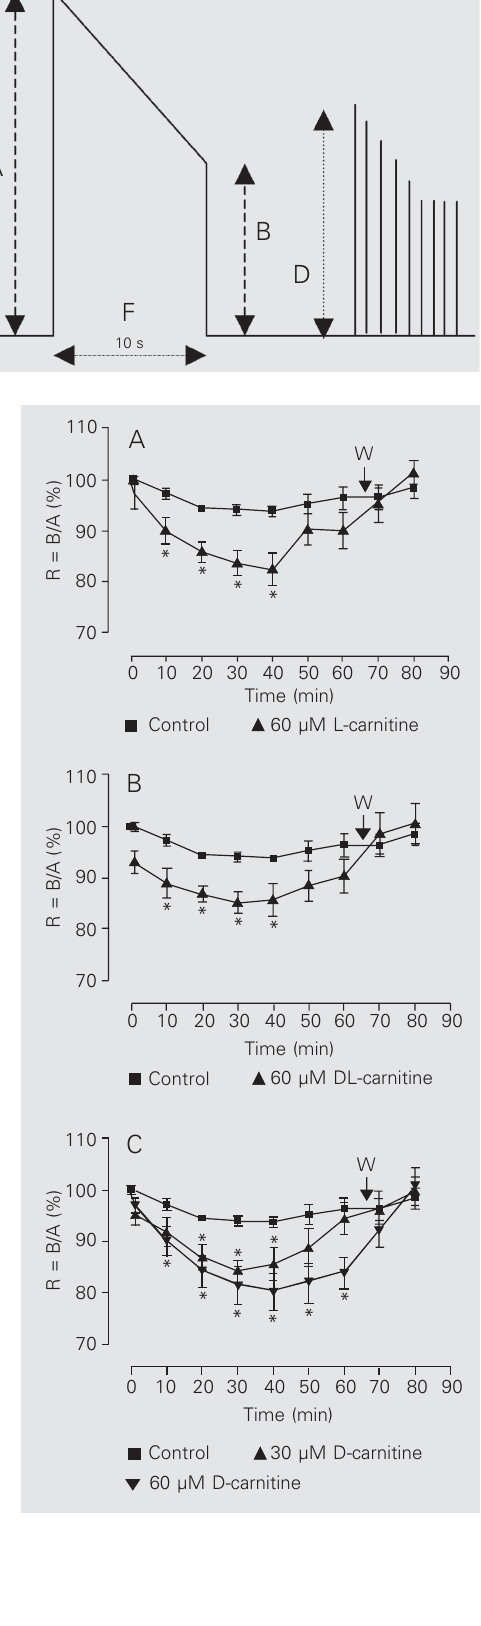
Figure 1. Representation of the contractile responses of rat skeletal muscle during tetanic stimulation. Tetanic fade is the ratio (R) between the tension at the end (B) and the tension at the beginning (A) of the tetanic response (R = B/A). C and D correspond to pre-tetanic and post-tetanic twitches, respec- tively. F indicates the stimula- tion rate required to obtain R = 0.5.